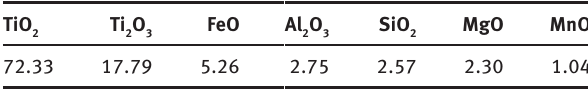
Table 1: Chemical composition of high titanium slag.